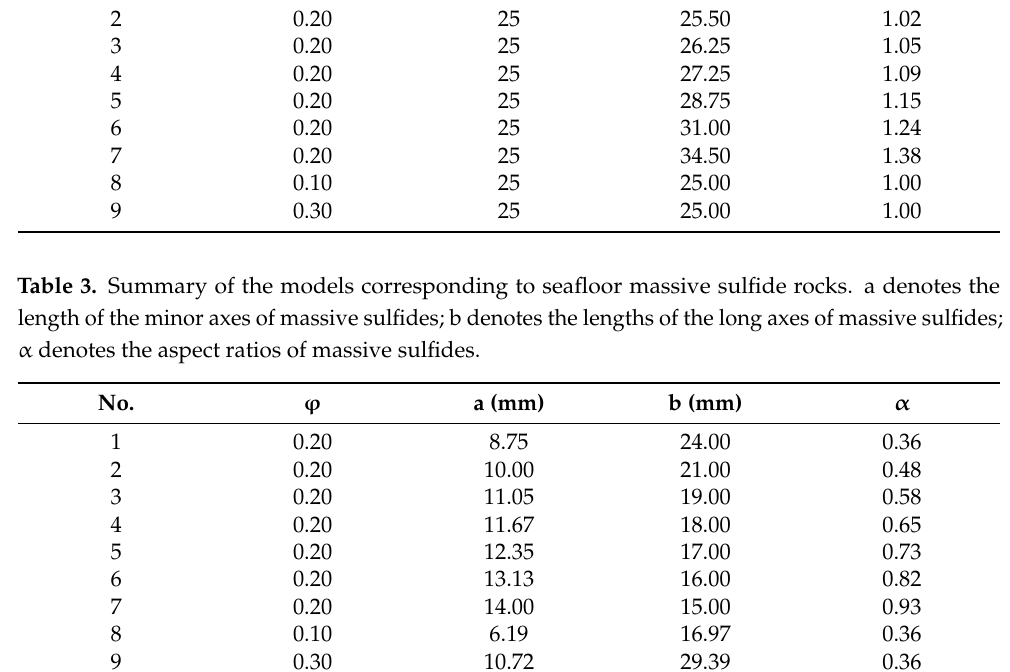
Table 2. Summary of the models corresponding to seafloor vein sulfide rocks. L1 denotes the distances between the ends of vein sulfides; L2 denotes the lengths of the long axes of vein sulfides. Table 1. Summary of the models corresponding to seafloor disseminated sulfide rocks. φ denotes No ϕ the volume contents of metal sulfides; r denotes the grain radii of sulfide particles. No.